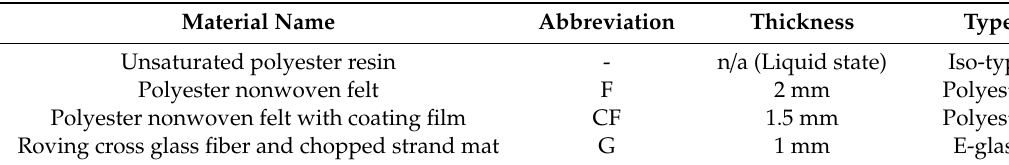
Table 2. Summary of materials and its characteristics for CIPP liner.